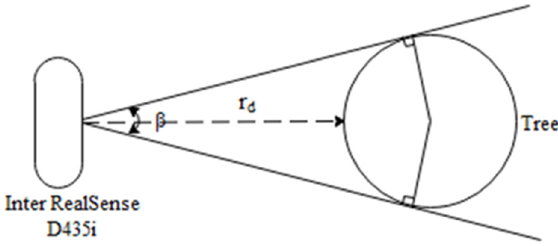
Table 3. Specific parameter list of Intel RealSense D435i.